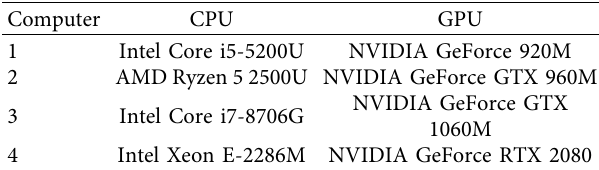
Table 2: CPU and GPU models of the four computers.